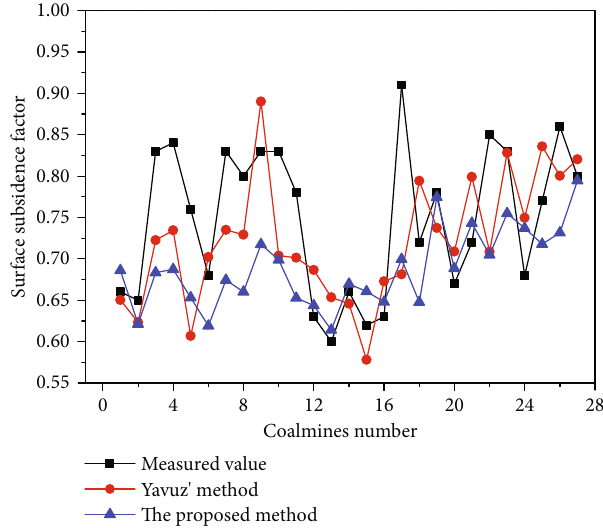
Figure 3: Comparison of the calculated and measured value of surface subsidence factor.